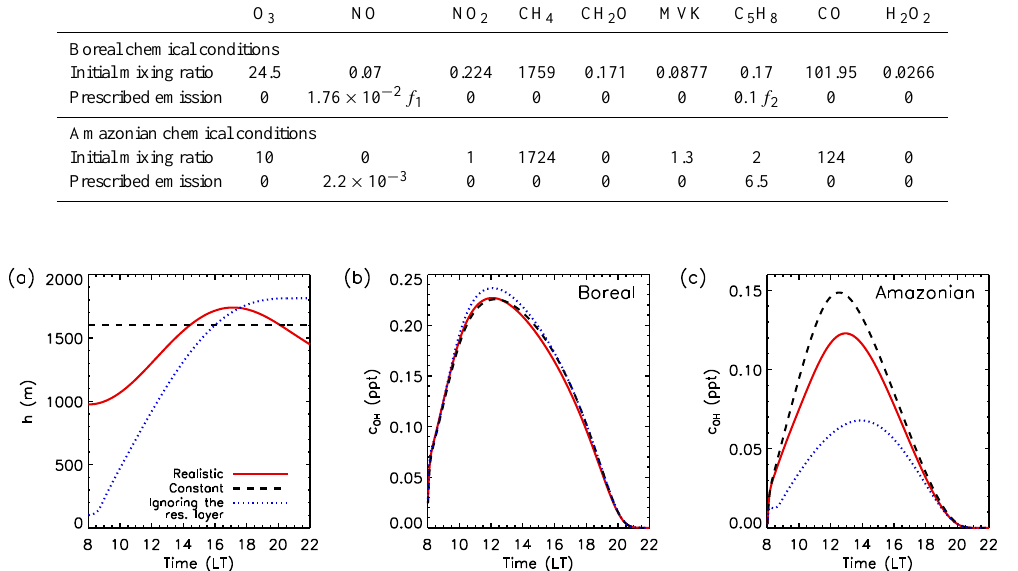
Fig. 7. Impact of (a) the ABL height development on (b, c) the mixing ratio of OH. Panels (b) and (c) present the results for initial chemical conditions and surface exchanges typical for boreal (as in HUMPPA-COPEC-2010) and Amazonian (Ouwersloot et al., 2011) conditions, respectively. Three cases are presented: (1) the boundary layer height as determined by the MXL model for 6 August 2010, (2) a constant boundary layer height and (3) a boundary layer height as determined by the MXL model if the residual layer would be considered as part of the free troposphere.